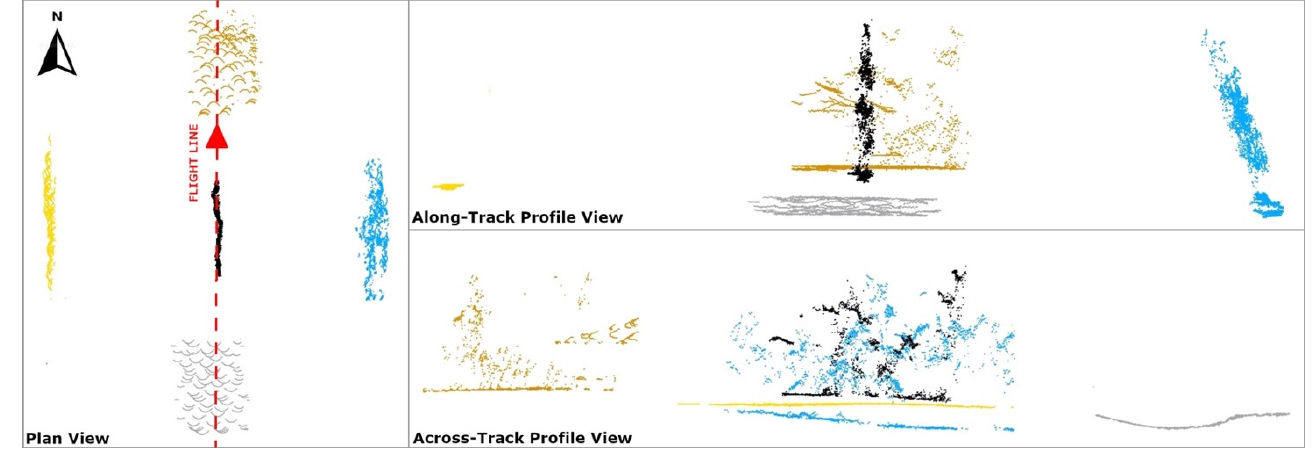
Figure 12. Views of a point cloud containing 5 s of collected data from the five FoV regions of the Mid-40 sensor.